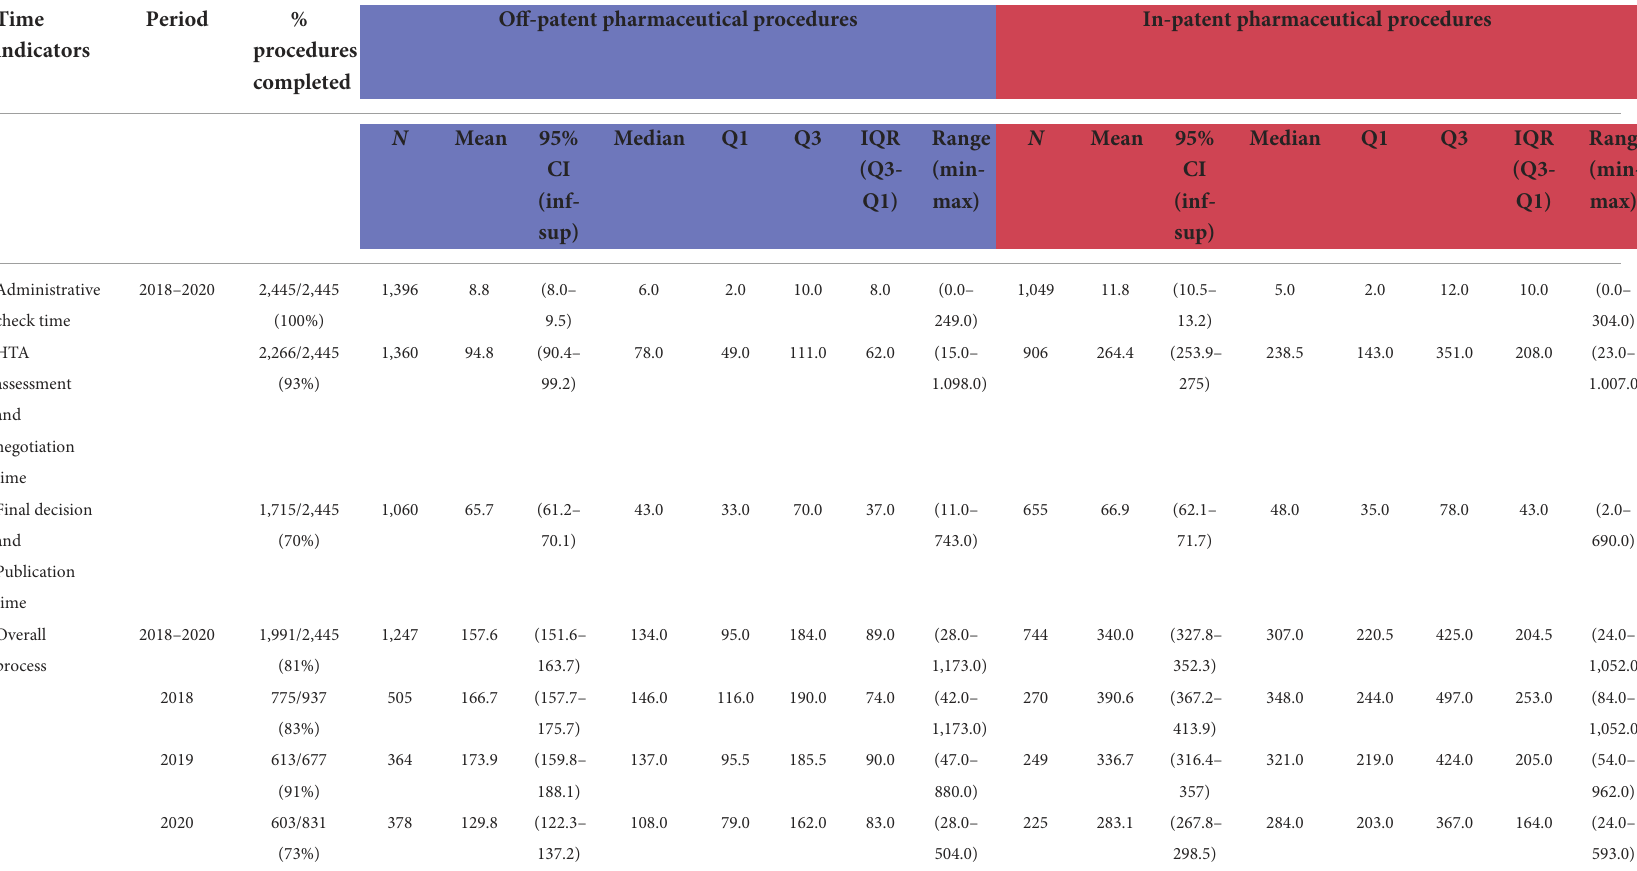
TABLE 2 Time in days indicators in the period 2018–2020, stratifying the procedure for Off-patent and In-patent